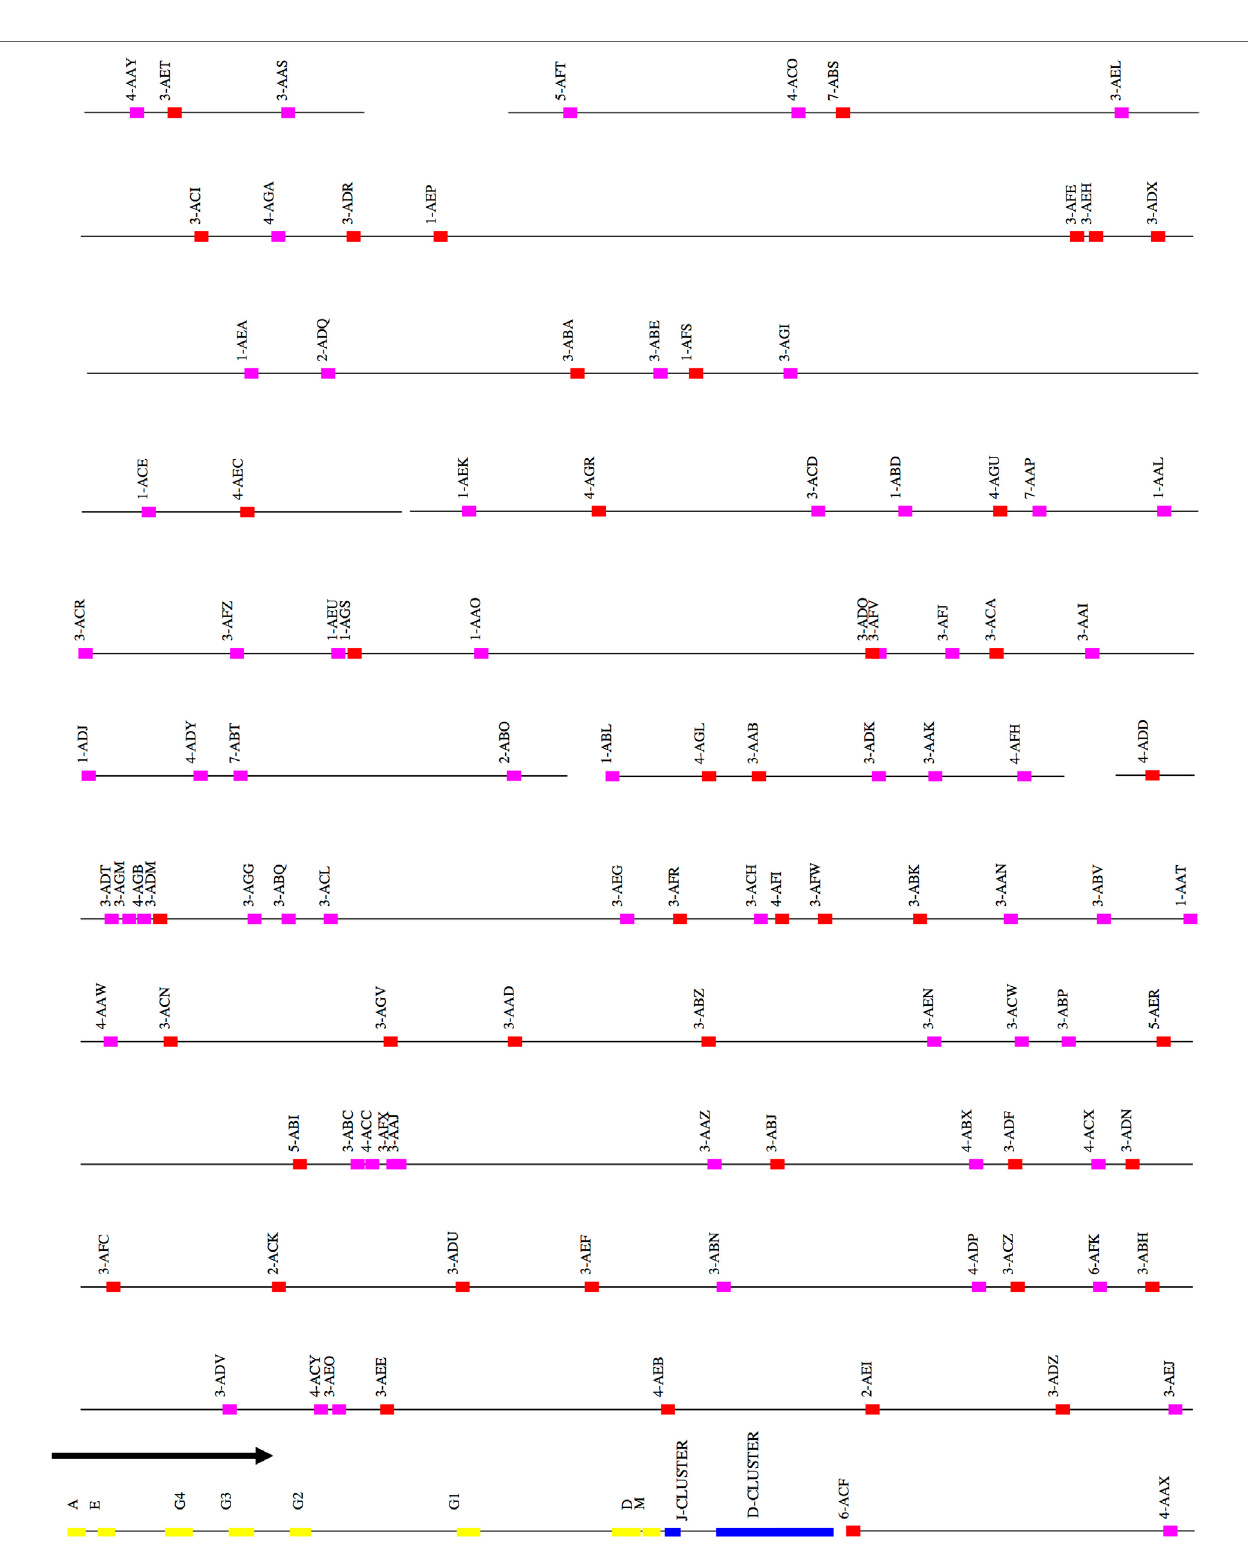
FigUre 1 | Schematic representation of the rhesus macaque IGH locus. A schematic representation of the rhesus IGH locus (plus strand). The order of the scaffolds was determined by ordering the rhesus macaque IGH scaffolds against the African Green Monkey IGH locus. The functional and non-functional genes are represented in red and magenta blocks, respectively. The J and D clusters are represented in blue blocks and constant region genes in yellow blocks. The constant region scaffold is one sixth the size of the other scaffolds in the figure—this was done to accommodate its large size compared to the IGHV